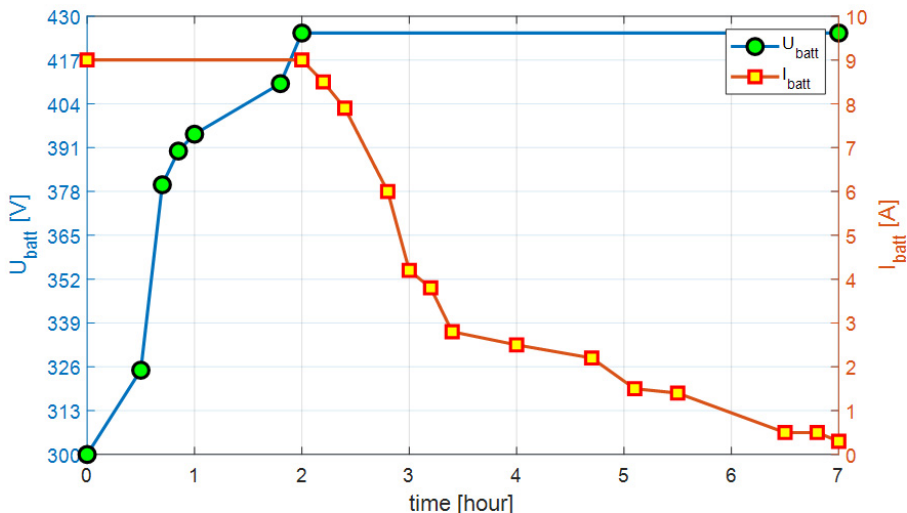
Figure 3. Battery charging cycle of Nissan Leaf [24].